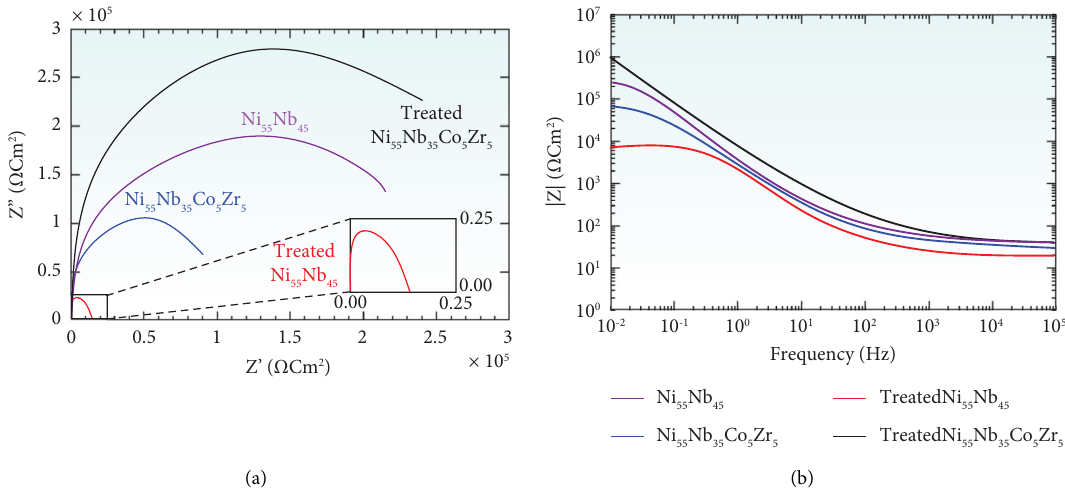
Figure 4: (a) EIS results of raw and treated samples, (b) the curves of | Z | value as a function of